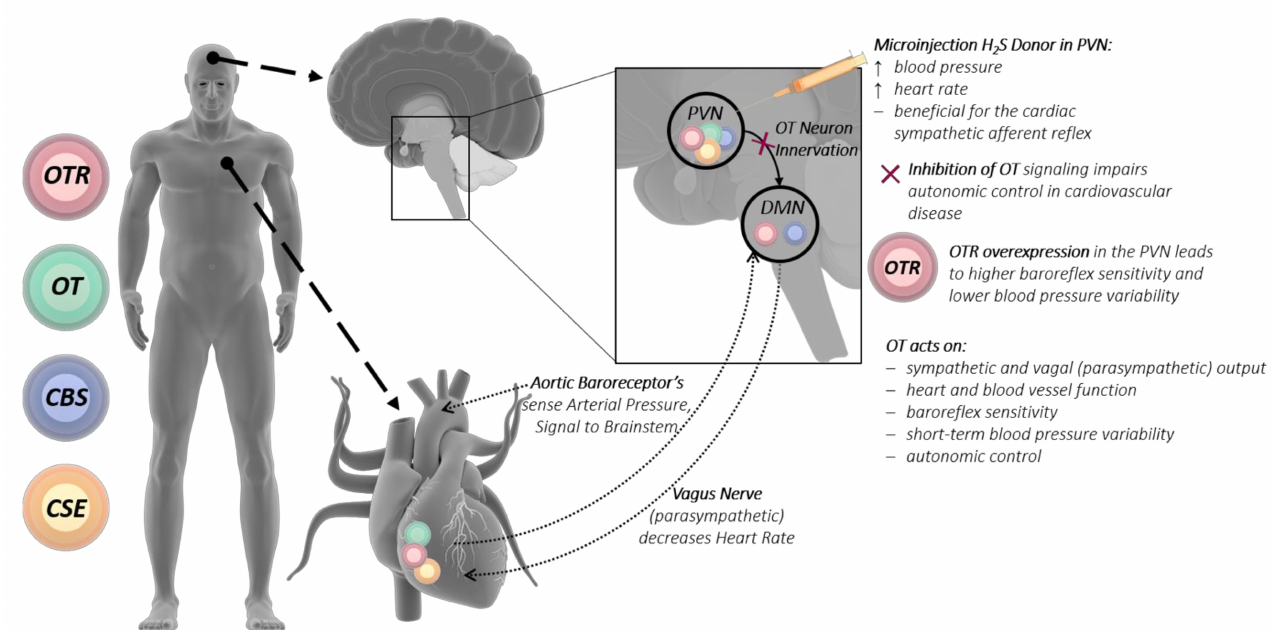
Figure 2. H 2 S and OT directly influence the vagus nerve, connecting heart and brain. Baroreceptors in large arteries sense the arterial pressure and signal to the DMN of the brainstem. The DMN also receives input from OT neurons of the hypothalamic PVN, which centrally regulates cardiovascular homeostasis. The vagus nerve (parasympathetic) signals from the DMN to the heart and decreases the heart rate. Notably, the OTR, OT, CBS, and CSE are expressed within the PVN. The OTR and CBS are expressed in the DMN, while cardiac tissue expresses the OTR, OT, and CSE. These expression patterns suggest a mutual interplay of the OT and H 2 S systems, connecting the heart and the brain. Pre-clinical studies show that acute trauma and/or chronic stress affects cardiac endogenous OT/R and CSE levels, thereby affecting physiological responses that influence the development of CVD. DMN: dorsal motor nucleus of the vagus nerve; PVN: paraventricular nucleus; OT: oxytocin; OTR: oxytocin receptor; CSE: cystathionine- γ -lyase; CBS: cytathionine- β -synthase; CVD: cardiovascular disease. Illustrations of the human, heart and brain were taken from the Library of Science and Medical lllustrations (somersault18:24,